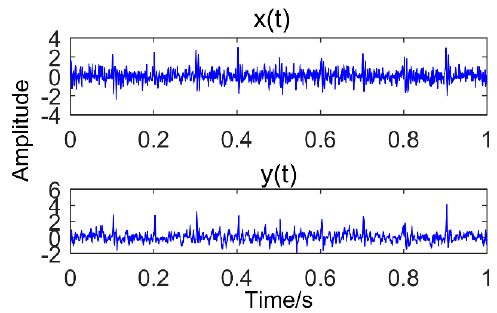
Figure 9. The original signal and the results obtained by Minimum Entropy Deconvolution Adjusted.